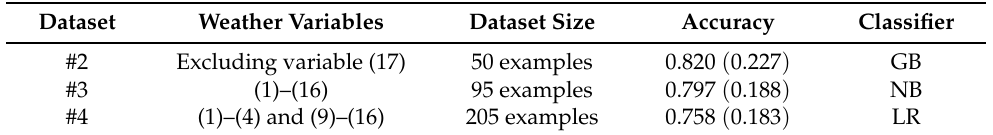
Table 8. Summary of results for LV datasets.